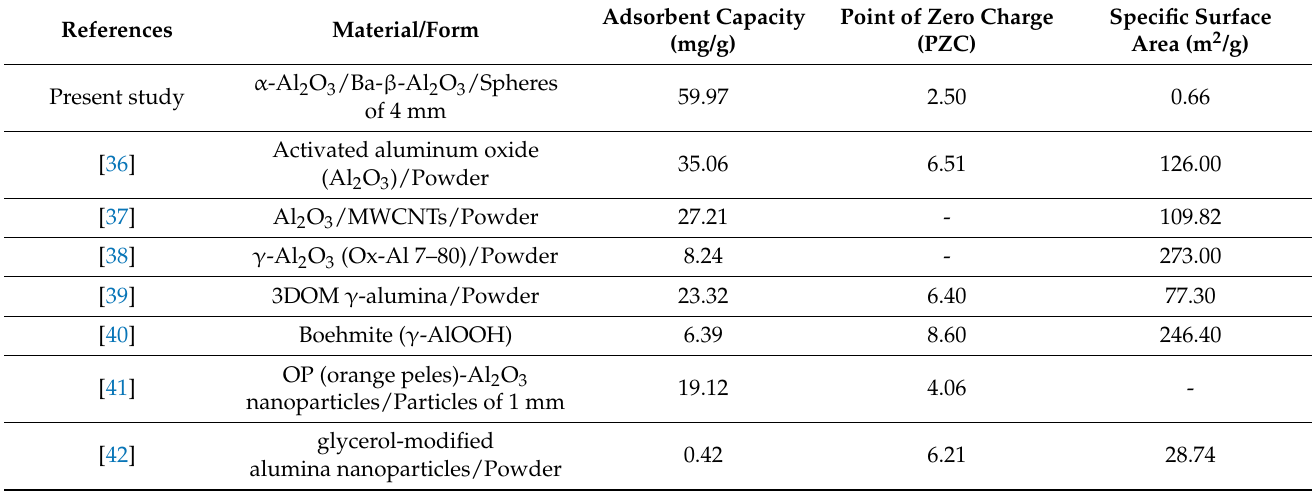
Table 5. Properties and adsorption capacities of Cd(II) of different alumina-based adsorbents.